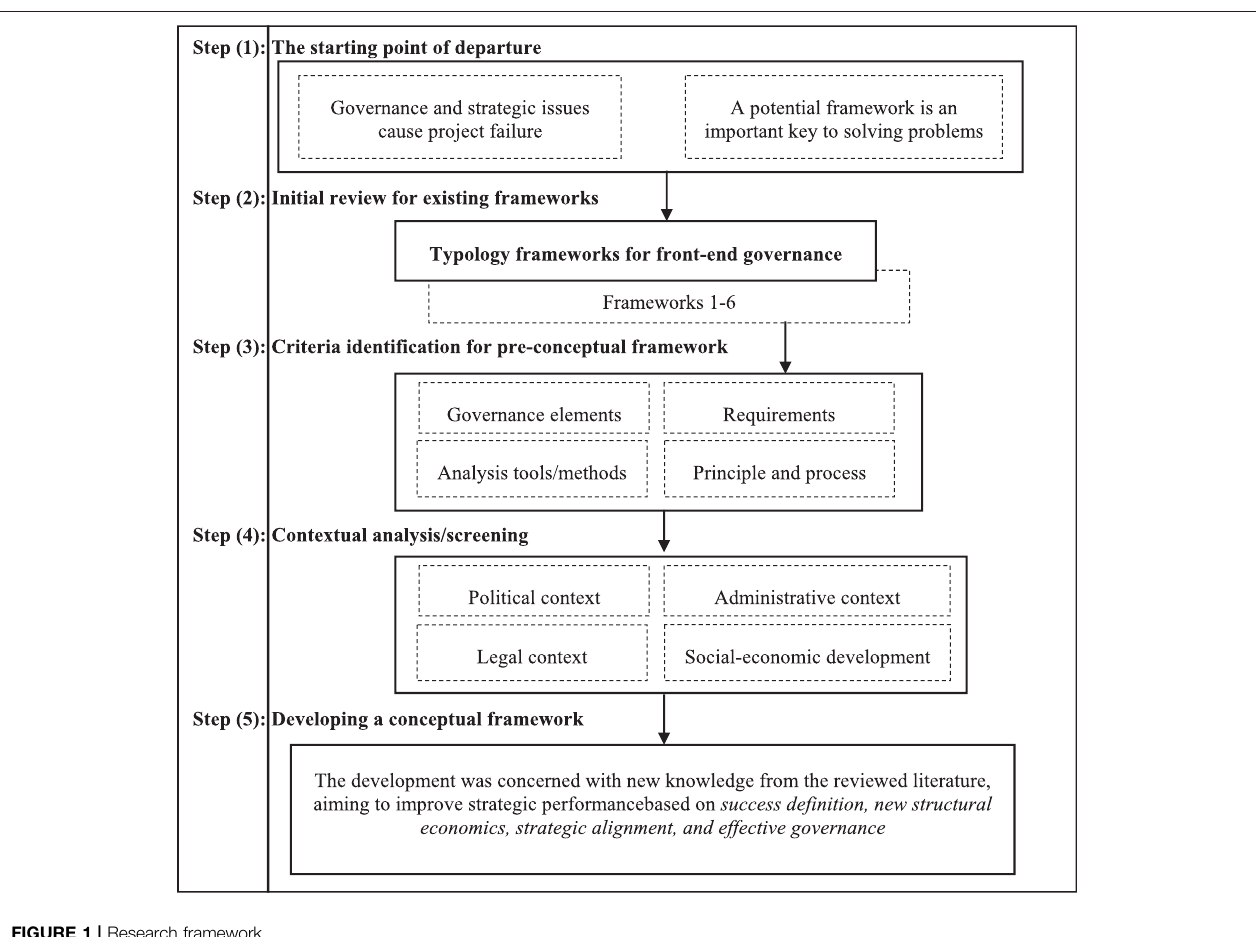
FIGURE 1 | Research